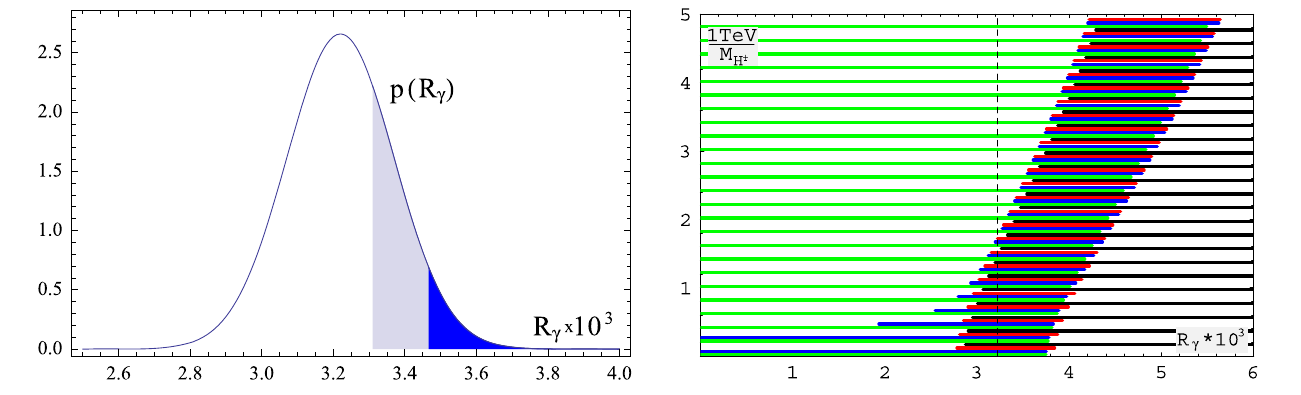
M H ± > 1276 GeV. Right Confidence belts (95% C.L.) in Model II for the same experimental error, and including the theoretical uncertainties (see the text). The experimental central value from Eq. (9) is marked by the vertical dashed